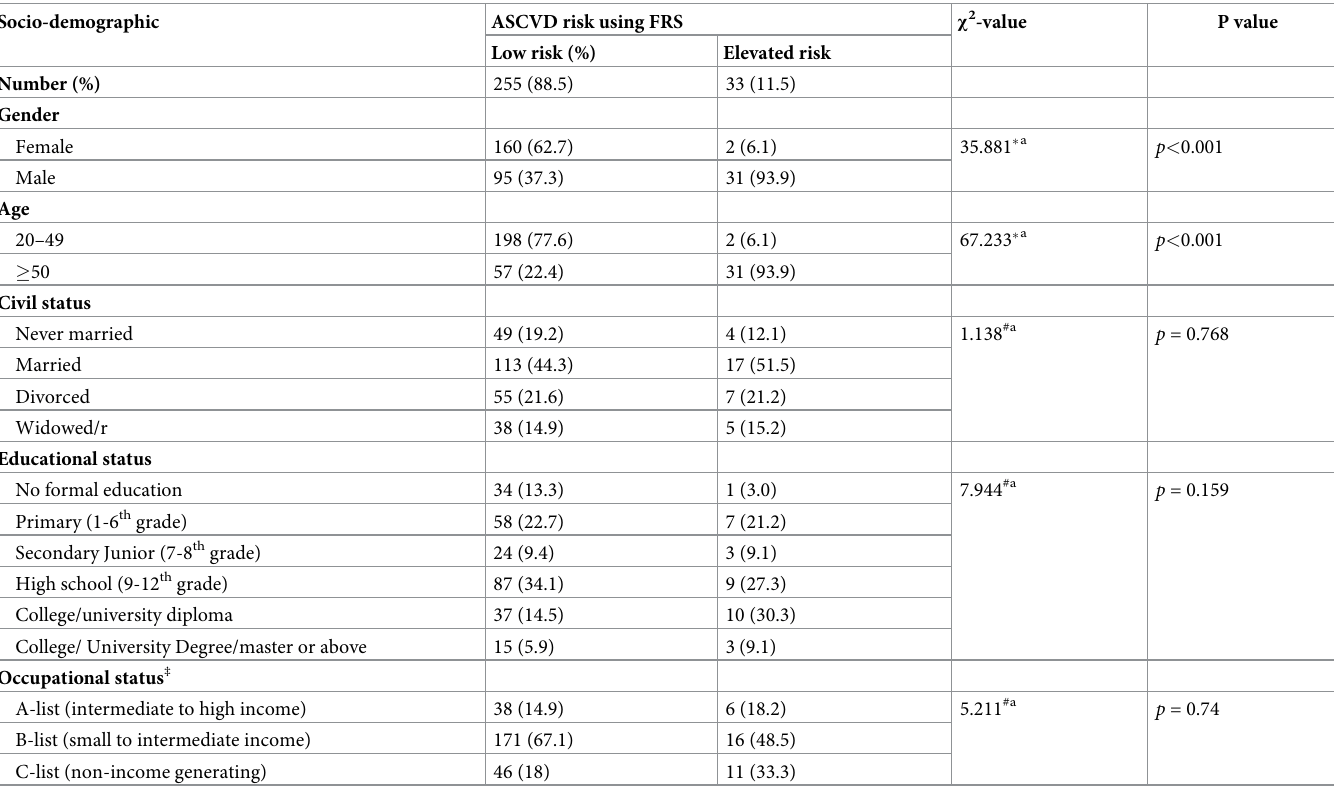
Table 1. Socio-demographic characteristics of HIV-infected patients with 20 and above years of age on ART follow up care at Zewditu Memorial Hospital, Addis Ababa,